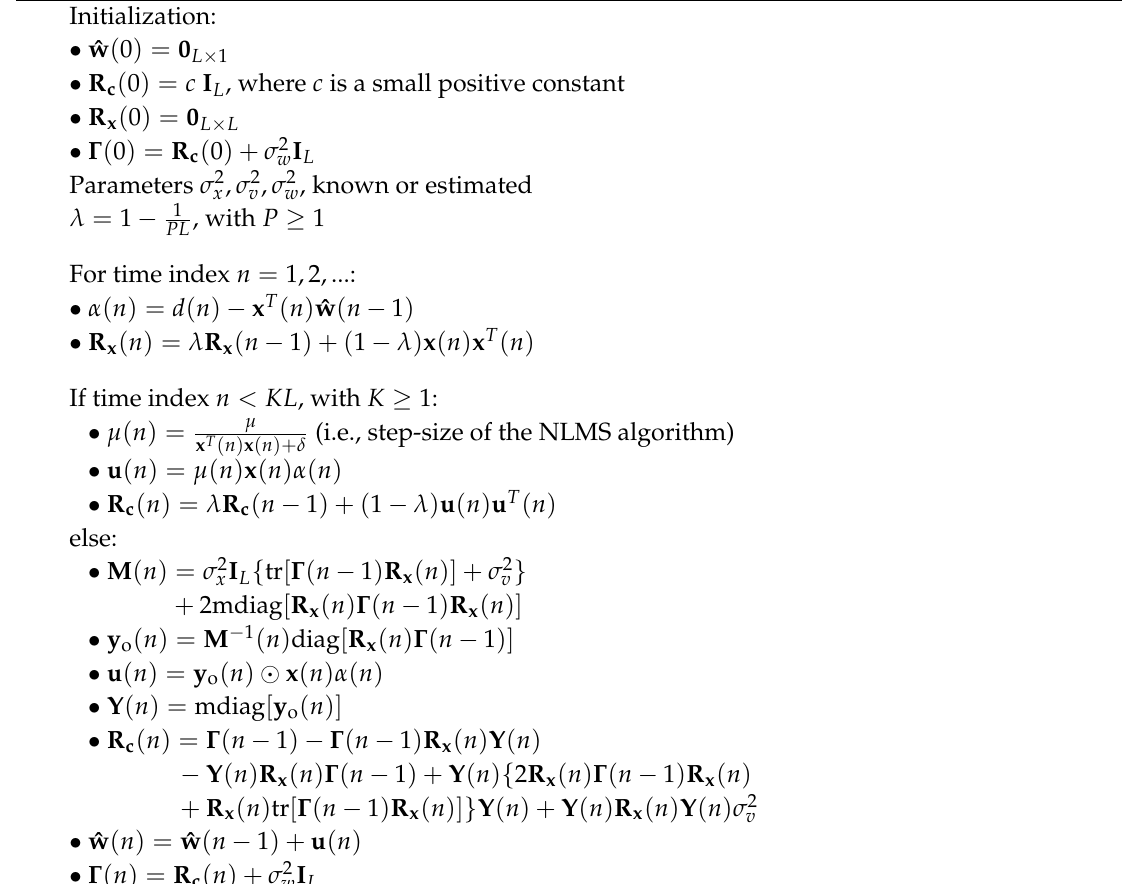
Algorithm 1: ODSS-LMS-G